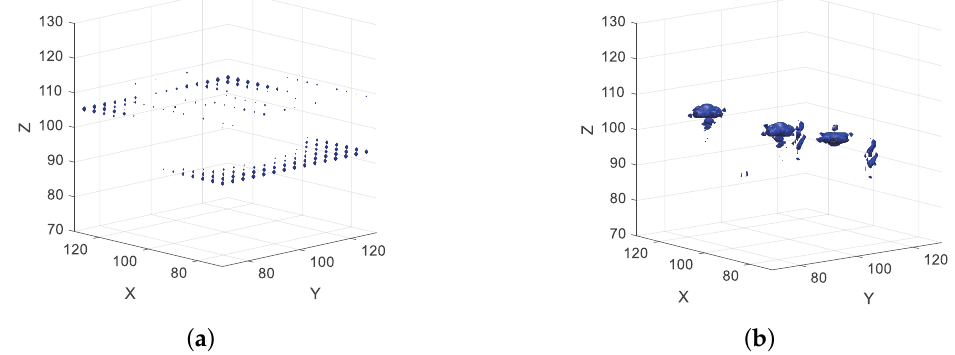
Figure 7. Three-dimensional inverse fast Fourier transform (IFFT) imaging results of 30% scan plane sparse sampling data. ( a ) SINC interpolation. ( b ) Orthogonal projection